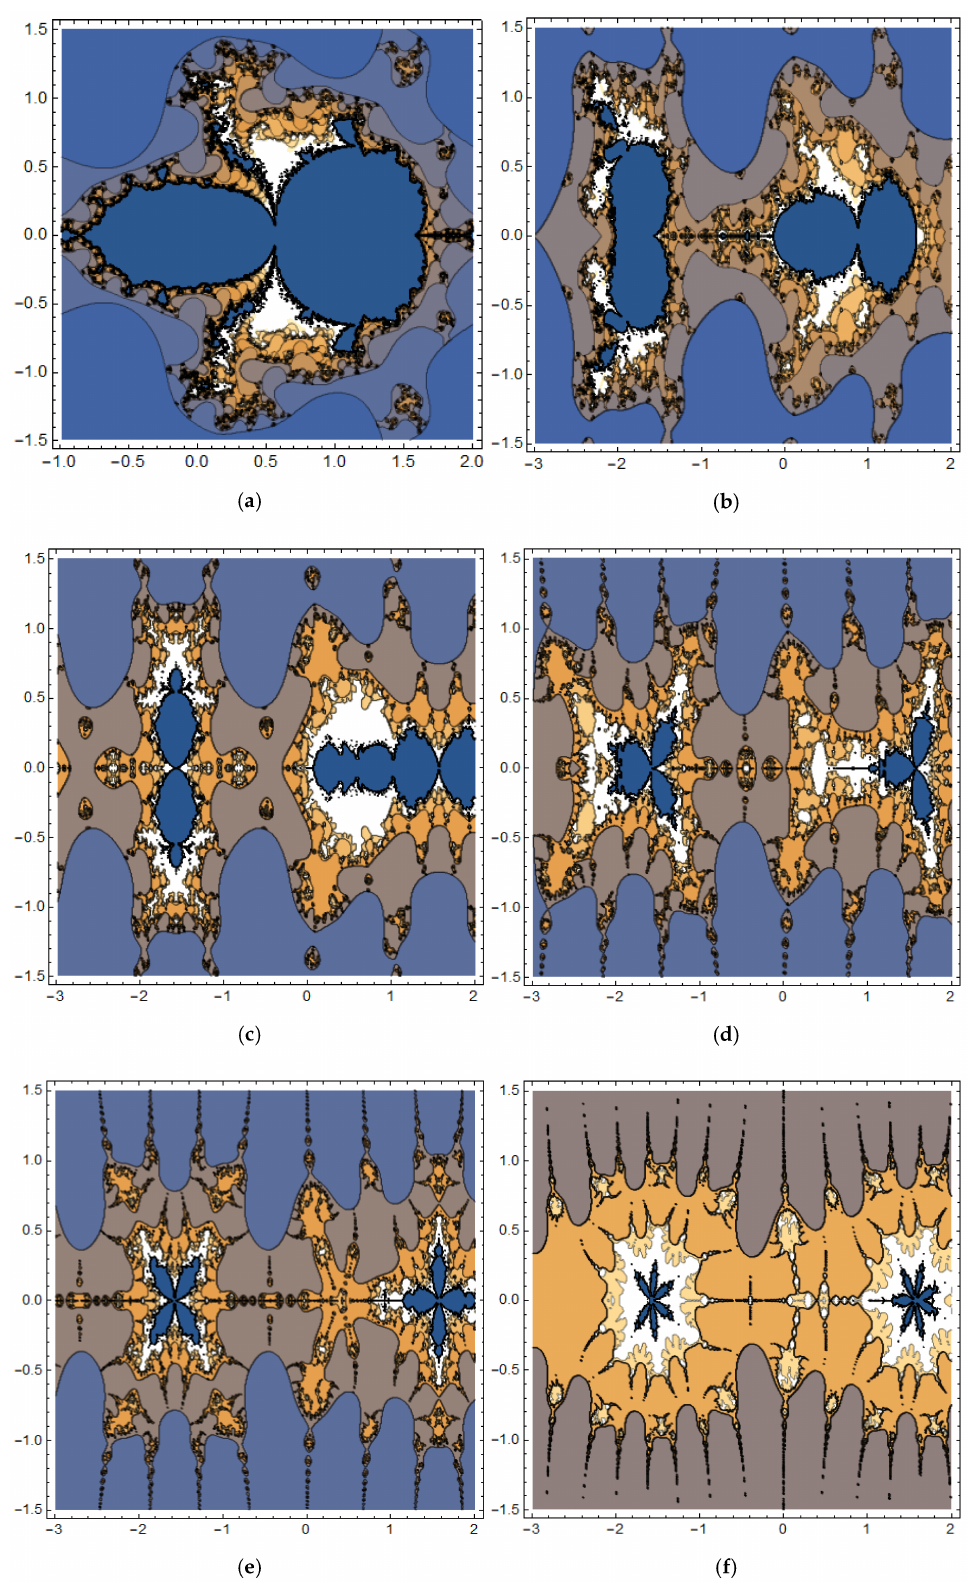
Figure 2. The Mandelbrot sets generated by the generalized fractional cosine map at α = 1, where ( a ) p = 2, ( b ) p = 2.5, ( c ) p = 3, ( d ) p = 4.3, ( e ) p = 5, and ( f ) p =